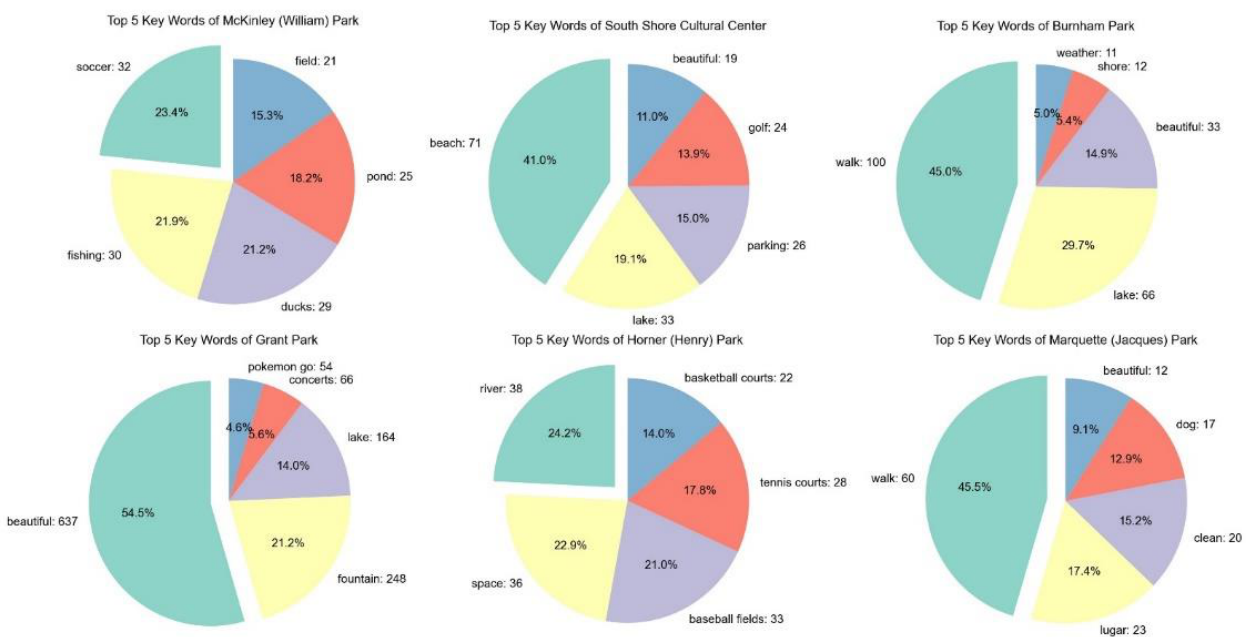
Figure 11. Pie charts of 6 selected parks for keywords analysis.